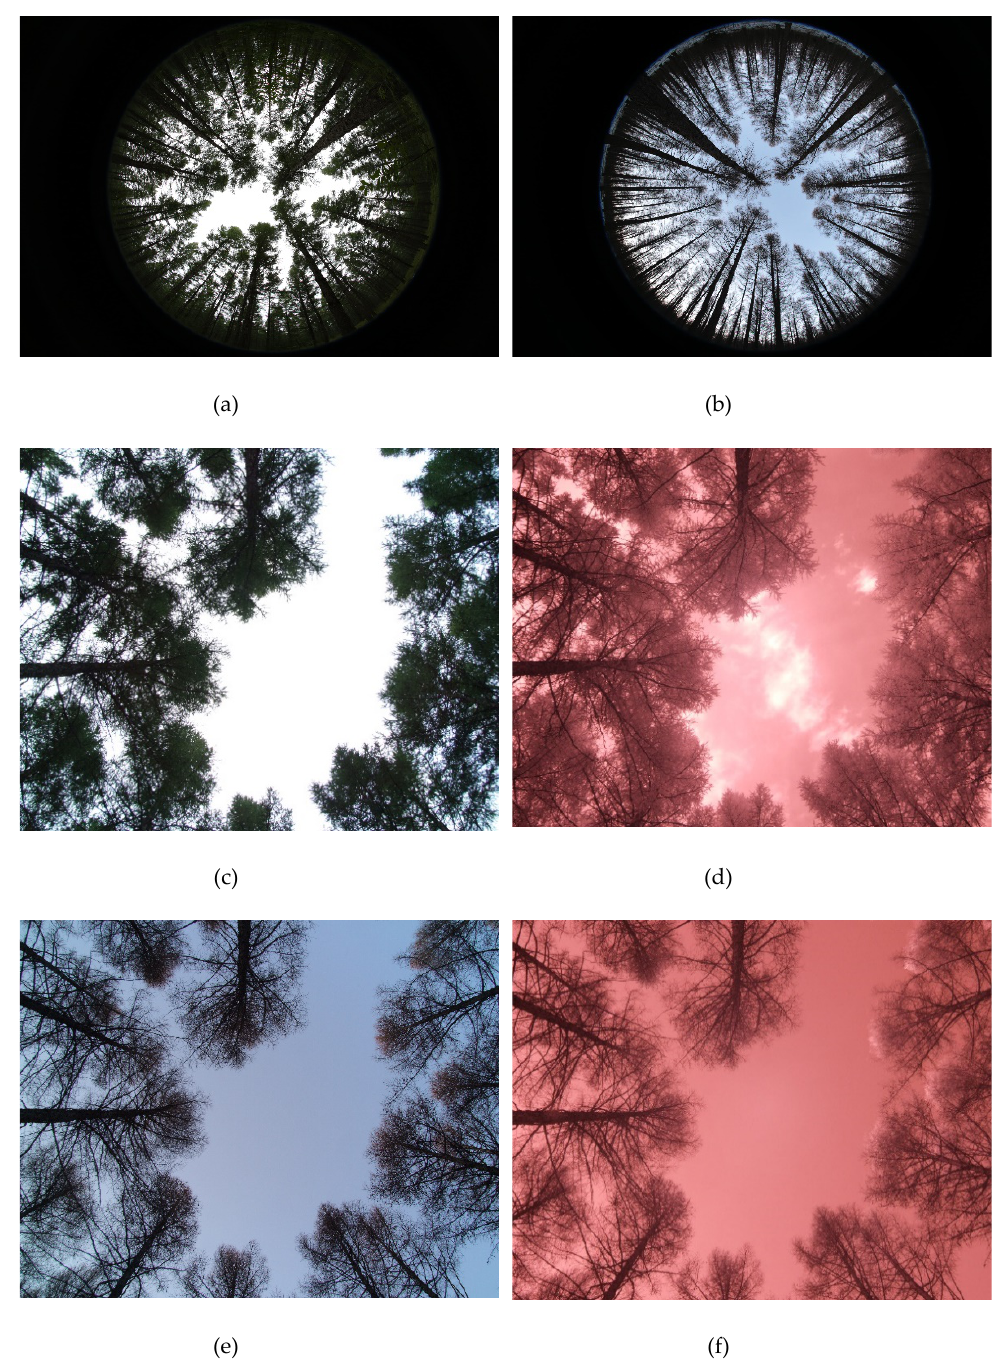
Figure 3. The DHP or multispectral canopy imager (MCI) images collected from the same sampling point or the same sampling point with the same zenith and horizontal angles at leaf-on and leaf-off periods in plot 1. ( a ) Leaf-on period DHP image, ( b ) leaf-off period DHP image, ( c ) leaf-on period visible (VIS) band MCI image, ( d ) leaf-on period near-infrared (NIR) band MCI image, ( e ) leaf-off period VIS band MCI image, and ( f ) leaf-off period NIR band MCI image.